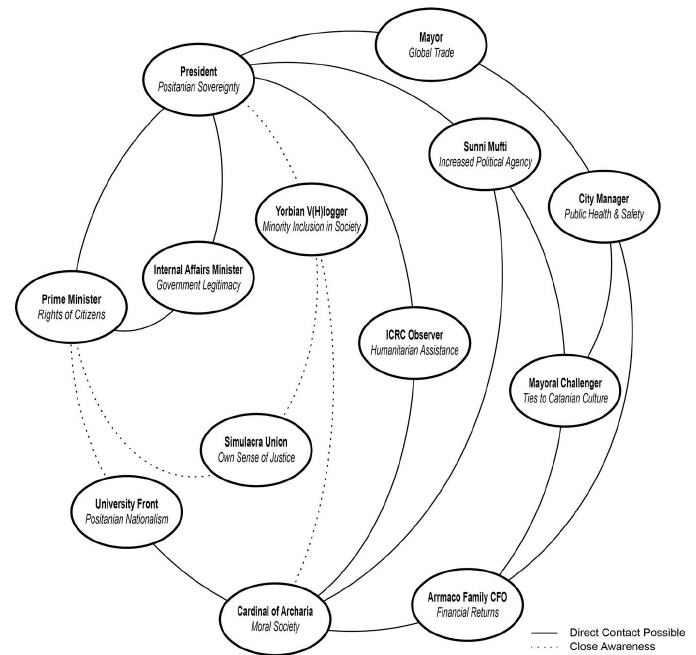
Archaria stakeholders, primary motivations and relationships (Source: Author, 2020).